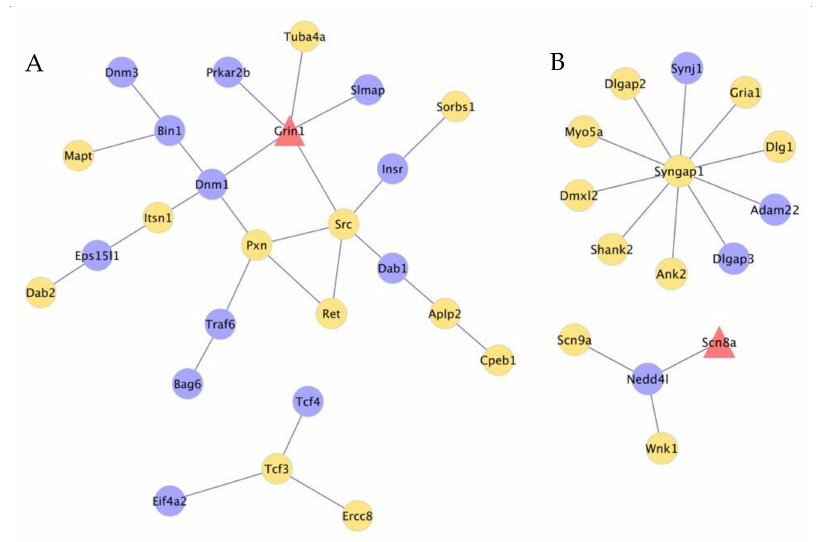
Figure 4. Network of genes presenting absolute or relative differential splicing between opioid- induced hyperalgesia and control mice in the nucleus accumbens ( A ) and trigeminal ganglia ( B ) Edges denote known gene relationships, and node color denote: red = genes presenting absolute and relative differential splicing; yellow = genes presenting absolute differential splicing; and blue = genes presenting relative differential splicing. Gene symbols: In the NAc Tuba4a, Prkar2b, Grin1, Slmap, Scrc, Insr, Sorbs1, Dab1, Aplp2, Cpeb1, Ret, Pxn, Prkar2b, Pxn, Dnm1, Bin1, Dnm3, Mapt, Itsn1, Eps14l1, Dab2, Traf6, Bag6, Tcf3, Tcf4, Eif4a2, Ercc8; In the TG Synj1, Gria1, Dig1, Adam22, Dlgap3, Ank2, Shank2, Dmxl2, Myo5a, Dlgap2, Nedd4al, Scn8a, Scn9a,